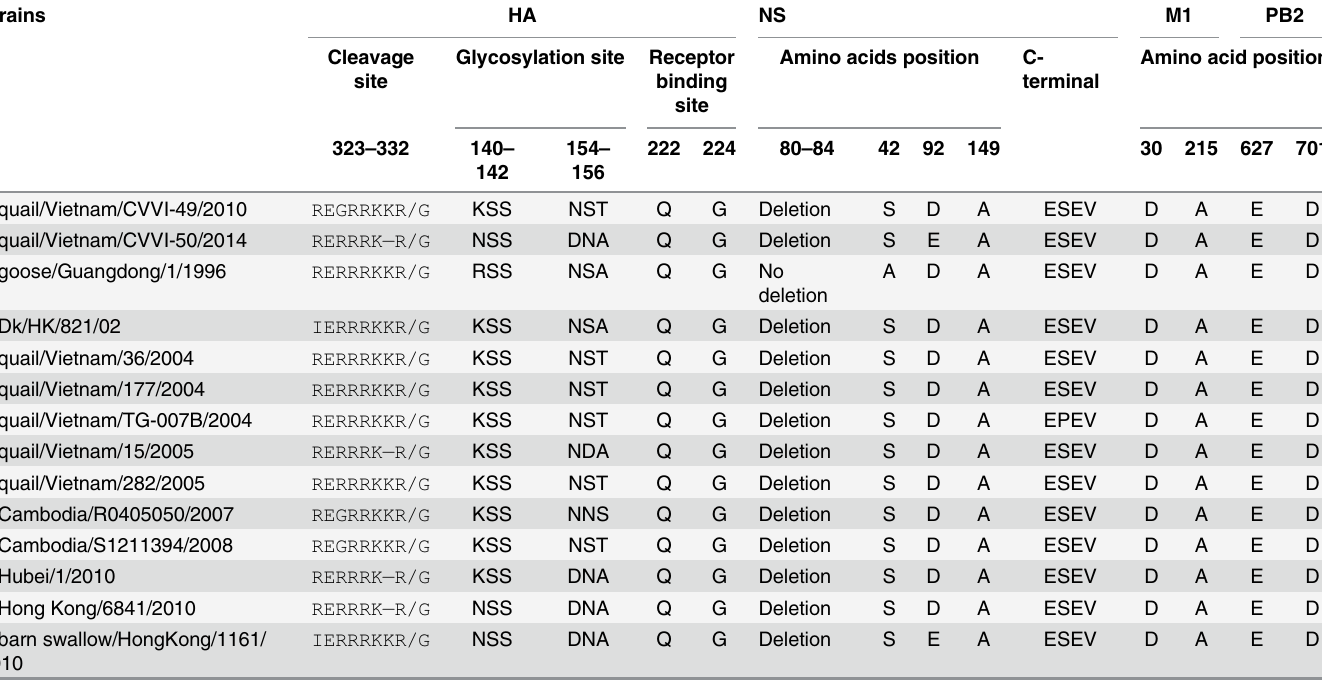
Table 1. Deduced amino acid sequences of the CVVI-49/2010 and CVVI-50/2014 strains relative to genetically related strains Strains